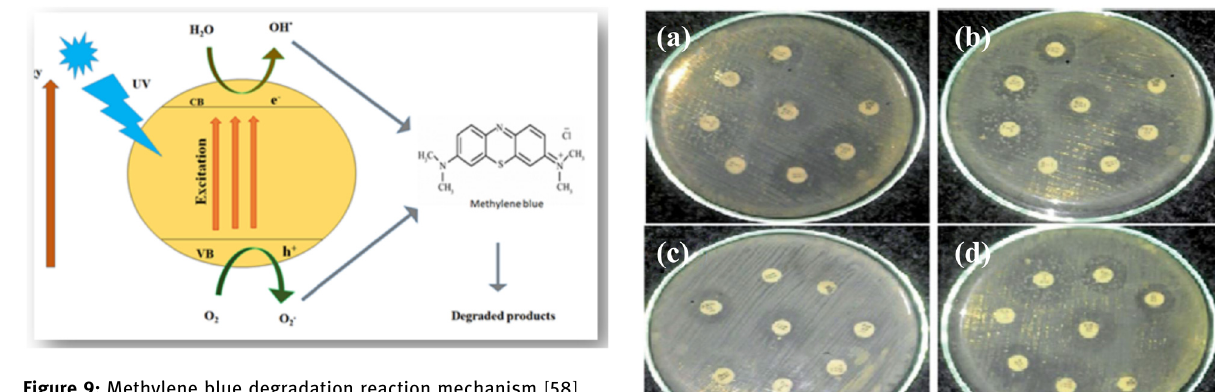
Figure 9: Methylene blue degradation reaction mechanism [ 58 ] .